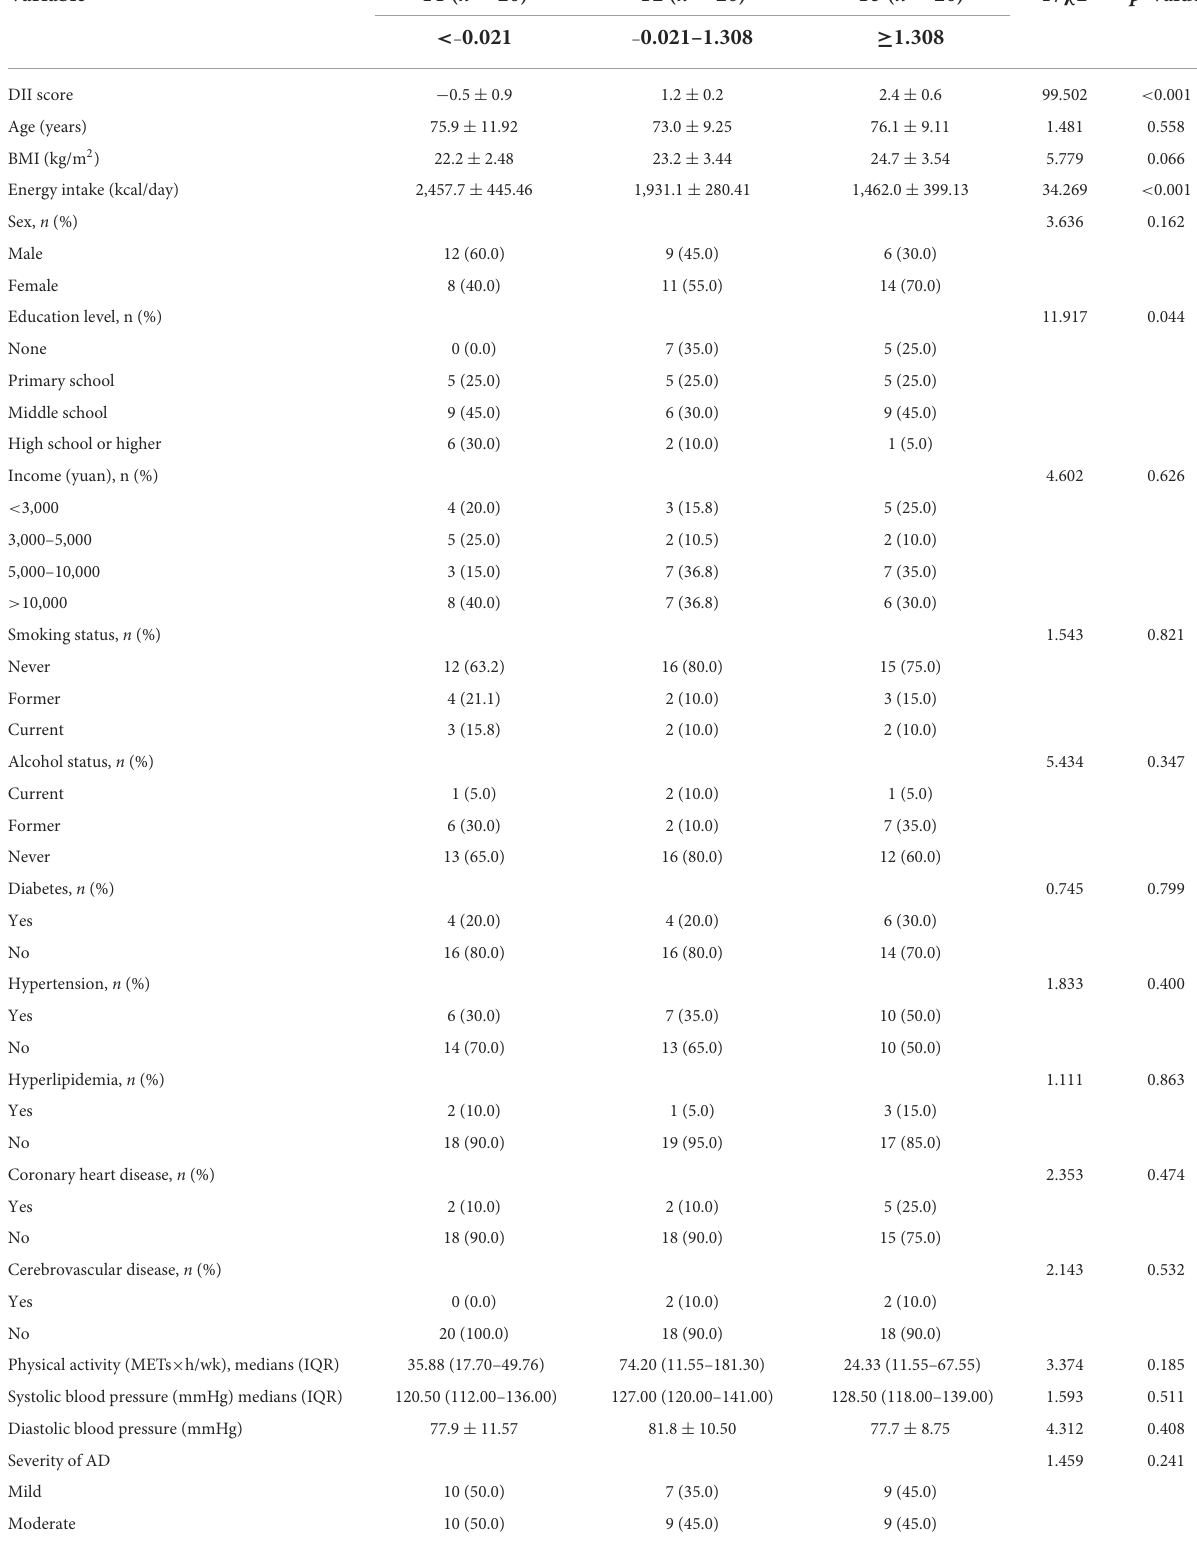
TABLE 2 Baseline characteristics of DII levels and inflammatory indicators in patients with